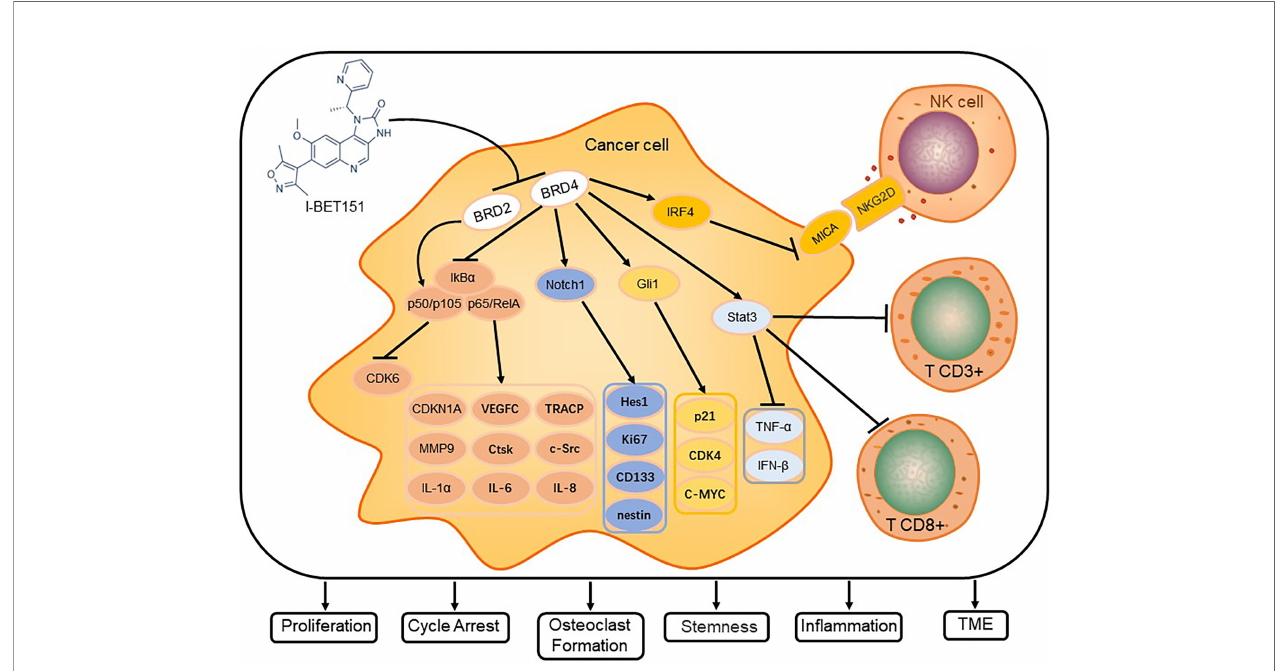
FIGURE 2 | I-BET151 affects the signal transduction in cancer cells and modulates critical cellular processes. I-BET151 speci fi cally inhibits BRD2 and BRD4, decreases the intracellular content of p50/p105, diminishes the degradation of IkB- a , prevents the dissociation of p50/p105 and p65/RelA from IkB- a and their transport into the nucleus, and decreases the activity of NF-B signal transduction. In addition, I-BET151 reduces the binding of BRD4 to the Notch1 and Gli1 promoter regions, inhibits the transcription of Notch1 and Gli1, and causes the target molecules of Notch and Hh signaling pathways to change. In the aspect of in fl uencing tumor microenvironment, I-BET151 not only targets BRD4, which leads to the increase of MICA expression and promoting NK cell degranulation, but also inhibits Stat3 signal, which leads to more CD3+ and CD8+ cells in tumors. Eventually, I-BET151 leads to cell cycle arrest, inhibition of cancer cell proliferation, stemness of stem cells, in fl ammatory factor release, osteoclast formation and regulation of